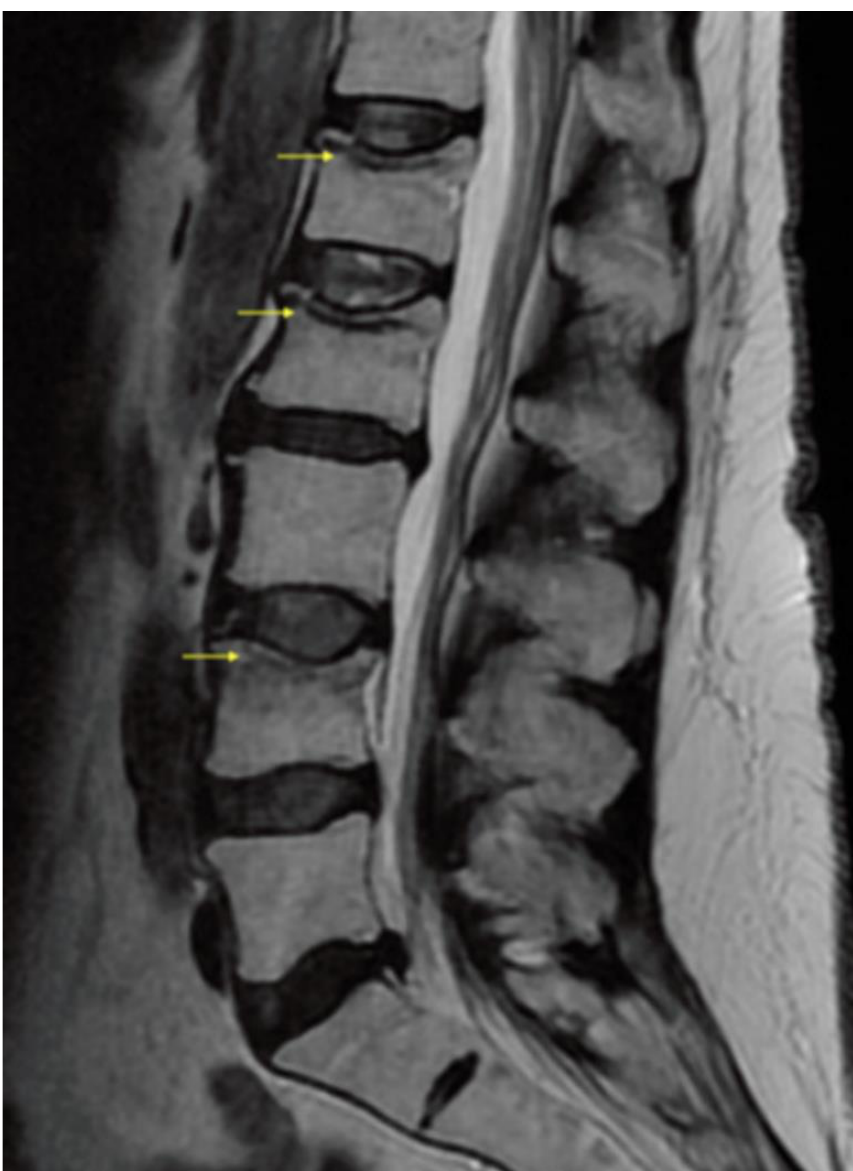
Figure 2. Lumbar spine magnetic resonance T2 image (MRI) with yellow arrows demonstrating superior endplate vertebral compression fractures of the L1, L2 and L4. There is mild postcontrast enhancement at the L1 and L2 compression fractures with minimal STIR hyperintensity edema and moderate postcontrast enhancement involving the superior L4 endplate.